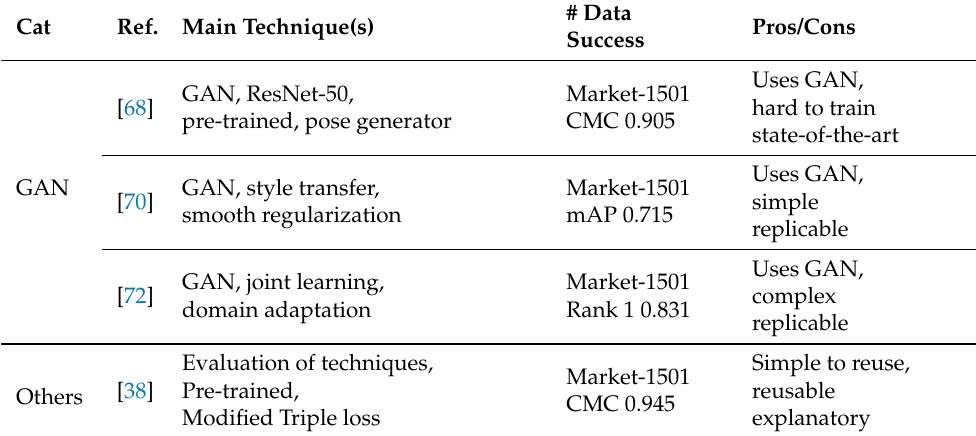
Table 5. Performance evaluation of the reviewed person ReID using generative